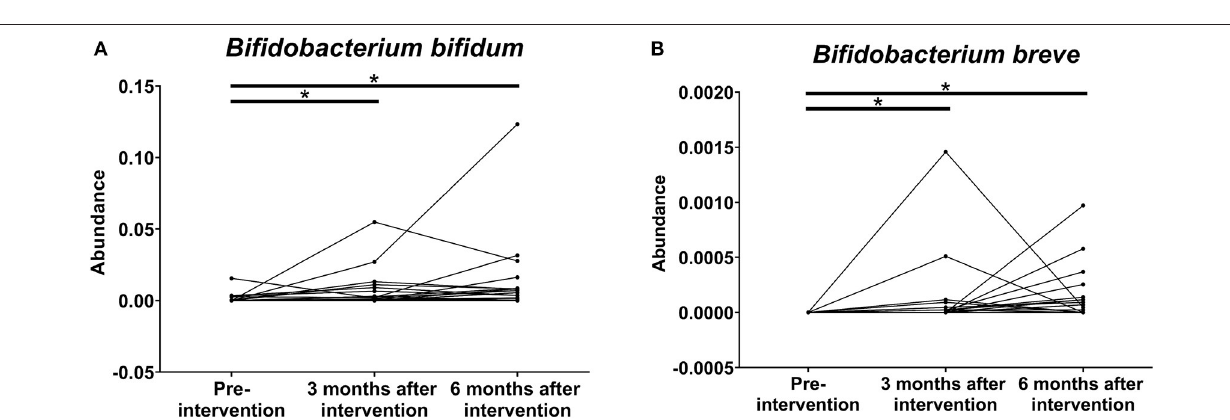
fecal samples among the patients on hemodialysis (27). In